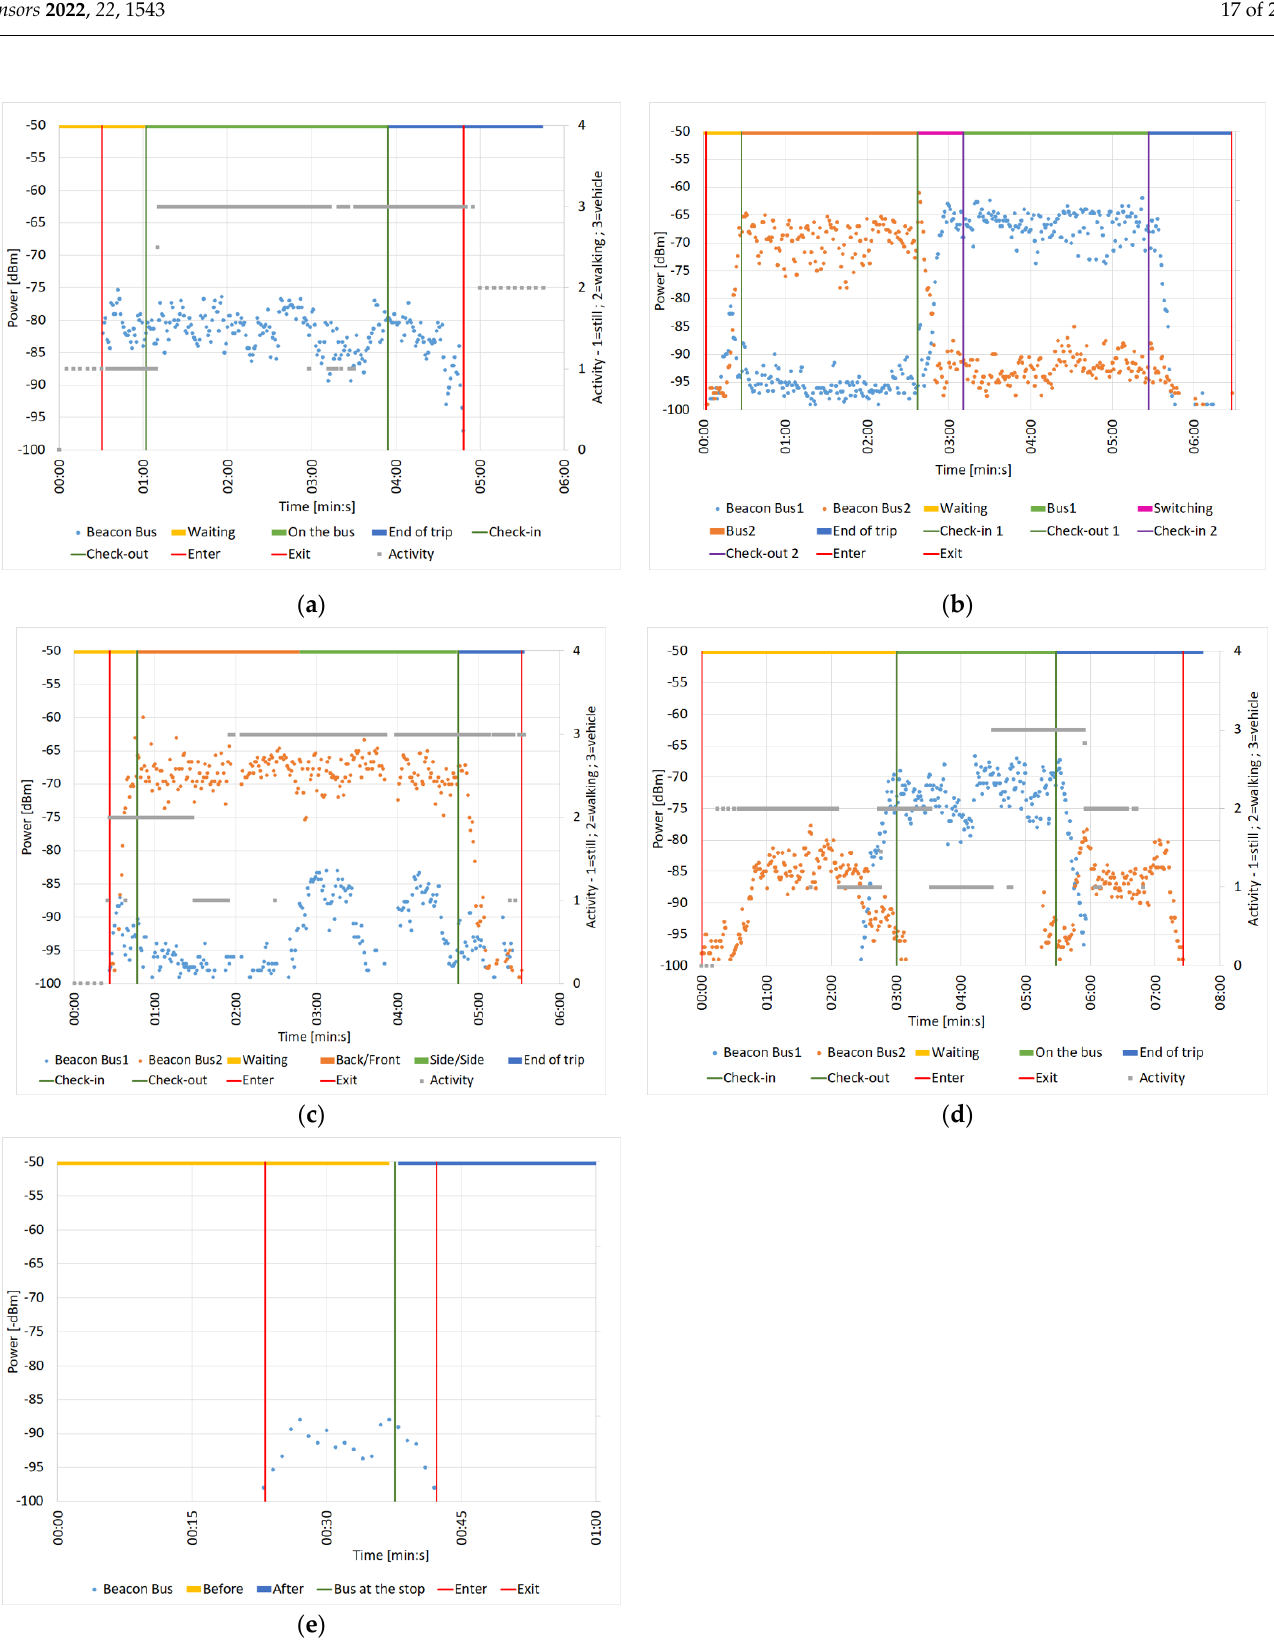
Figure 8. Results of the first batch of tests for different scenarios. ( a ) Detecting beacons while riding on a bus; ( b ) switching from a bus to another; ( c ) detecting beacons placed on two different buses; ( d ) waiting at a bus stop where a bus is idle; ( e ) waiting at a bus stop with no nearby buses.